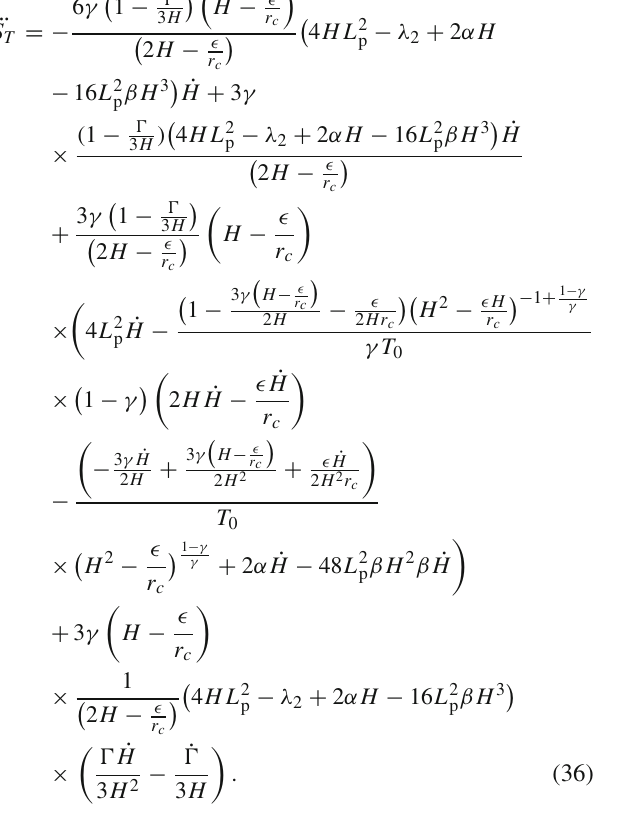
Figure 6 reperesents the plot between values of T for variable (cid:2) for same constant values. Fig- ure 6 indicates that the trajectories of all the values of T ensure the validity of thermodynamical ¨ S T < 0 for